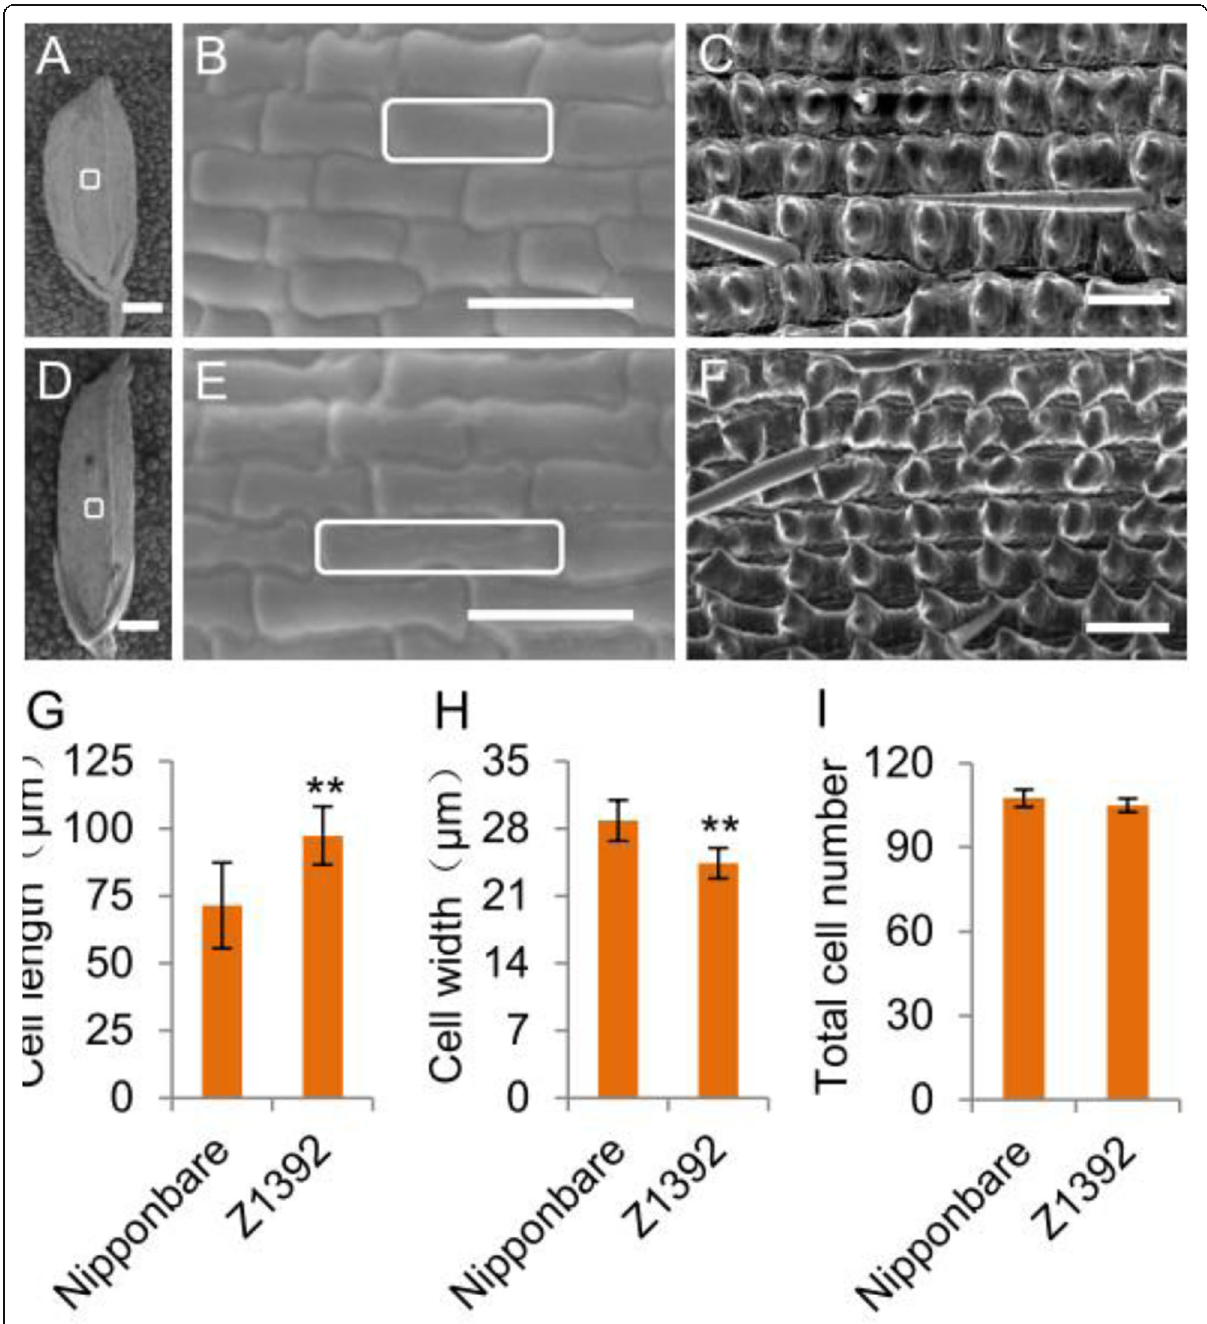
Fig. 3 Scanning electron microscopic observation and analysis of the glume. a – c , Scanning electron micrograph of the lemma ( a , d ), and inner epidermis ( b , e ) and outer epidermis ( c , f ) of the glume of Nipponbare ( a - c ) and Z1392 ( d - f ). g - h , Cell length and cell width in the inner epidermis of the lemma of Nipponbare and Z1392. i , Total cell number in the outer epidermis of the lemma along the longitudinal axis of Nipponbare and Z1392. Bars in A and B, 1 mm; B, C, E and F, 100 μ m. * and ** indicate a significant difference between the two parents at P < 0.05 and P < 0.01, lines were obtained from each individual. Ten individ- F Analysis of Additive and Epistatic Effects of QTLs on Grain 3 uals for each F line were sampled for further molecular Length 3 marker selection using heterozygous markers in the se- On the basis of the QTL mapping results, eight individ- lected plant lines. Ultimately, three SSSLs (S1, S2, and uals were selected from the F population by MAS, and 2